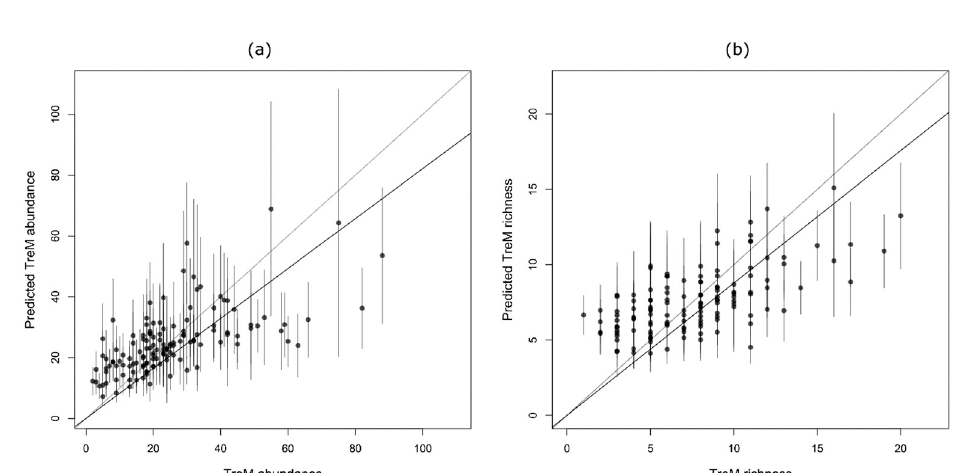
Figure 4. Observed vs. predicted abundance ( a ) and richness ( b ) of tree-related microhabitats. The predicted TreM abundance and richness (y-axes) is compared with the observed one (x-axes). The 1:1 lines are displayed in light grey, while the trend-lines are black and have a fixed intercept of 0. The whiskers show the 95% confidence interval of the prediction.